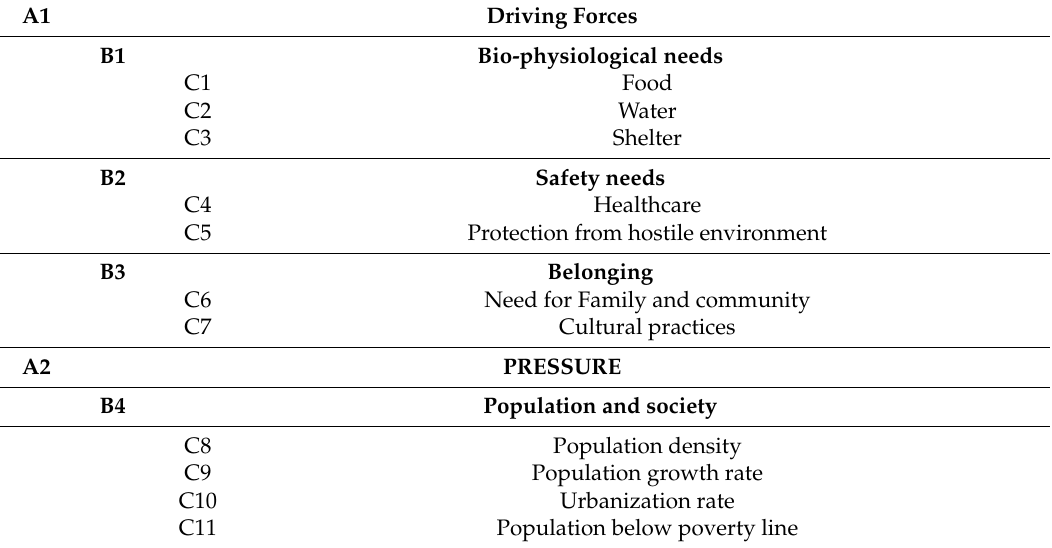
Table 1. Environmental Risk indicator System for Dar es Salaam